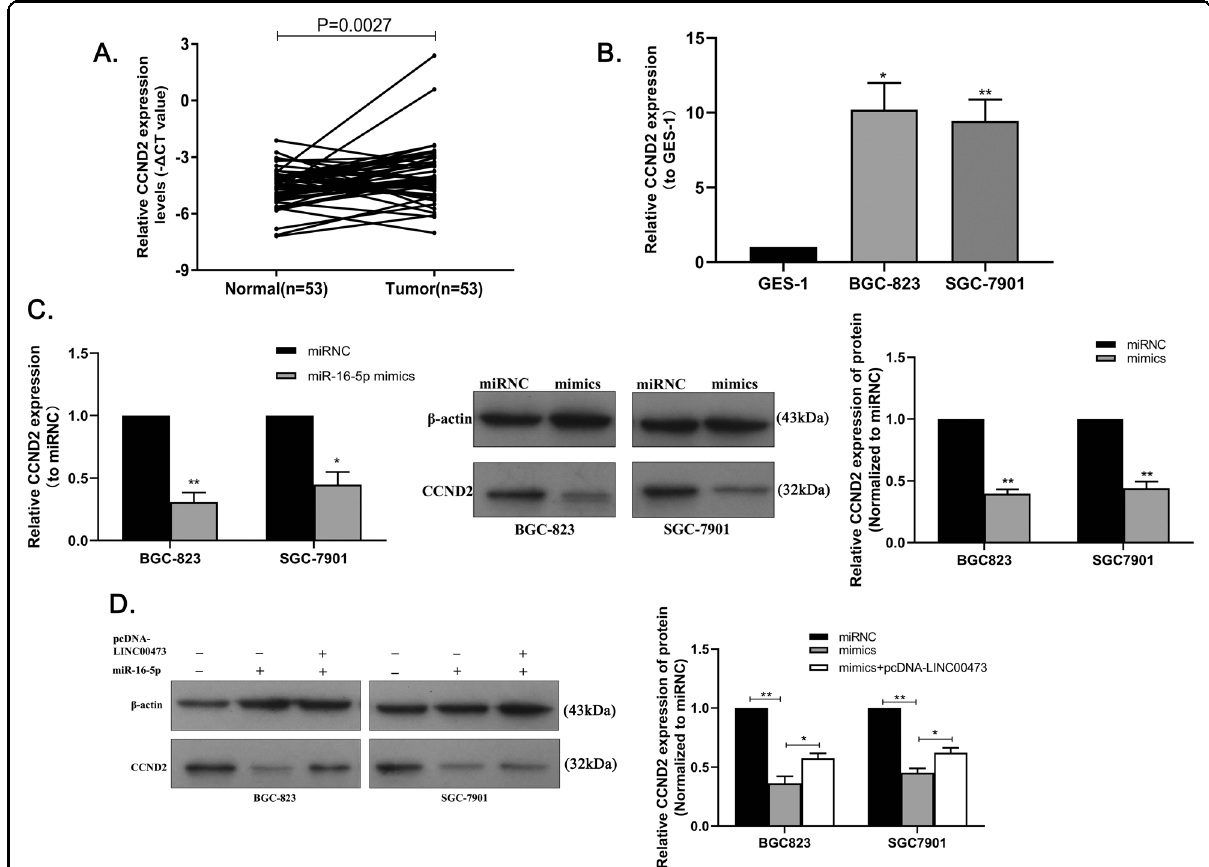
Fig. 6 MiR-16-5p sponged by LINC00473 can regulate the expression of CCND2. A Relative expression of CCND2 in GC tissues ( n = 53) compared with the corresponding non-tumor tissues ( n = 53) was analyzed by qRT-PCR and normalized against GAPDH expression. The data were analyzed by the paired two-tailed t test ( P = 0.0027). B The expression of CCND2 in BGC823 and SGC7901 cell lines were detected by qRT-PCR compared with GES-1 expression. C Relative expression of CCND2 in BGC823 and SGC7901 cells treated with miR-16-5p mimics both in mRNA and protein level. D The alteration of CCND2 protein expression in BGC823 and SGC7901 cells was observed with co-transfected with miR-16-5p mimics and pcDNA-LINC00473. Values are shown as the mean ± SD based on three independent experiments. * P < 0.05, ** P <